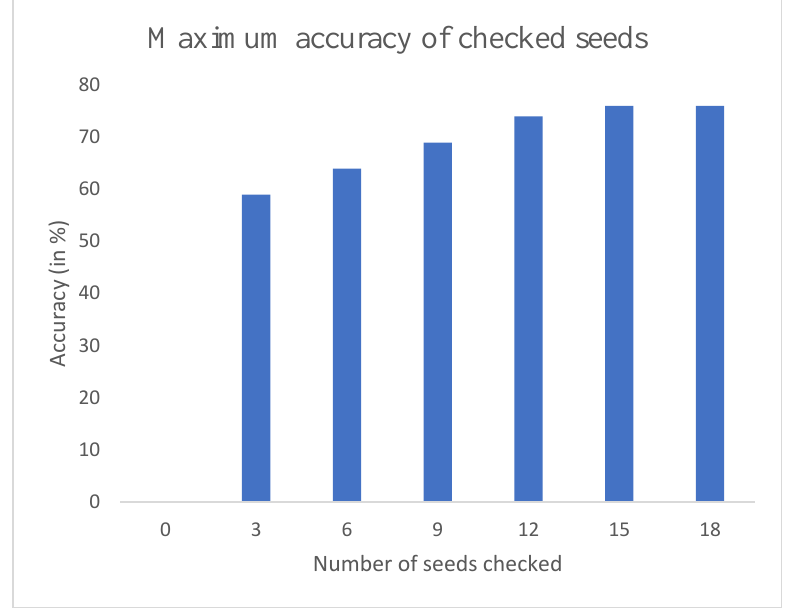
Figure 5. Accuracies for the evolved seeds in the network.